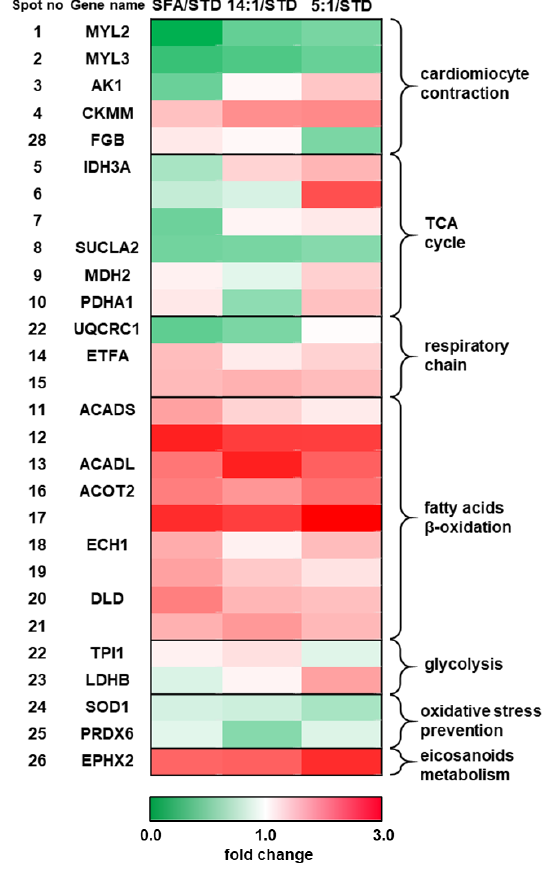
Figure 3. Heat map representing the identified proteins according to the magnitude of fold-change in the myocardium of mice fed high-fat diets with different fatty acid composition (SFA, n6/n3 PUFA 14:1, n6/n3 PUFA 14:1) compared to group of mice fed a standard diet (STD). Proteins were grouped according to their involvement in biological processes. Spot numbers refer to those presented on the 2-D proteome map (Figure 2) and Table 3. TCA - tricarboxylic acid cycle.